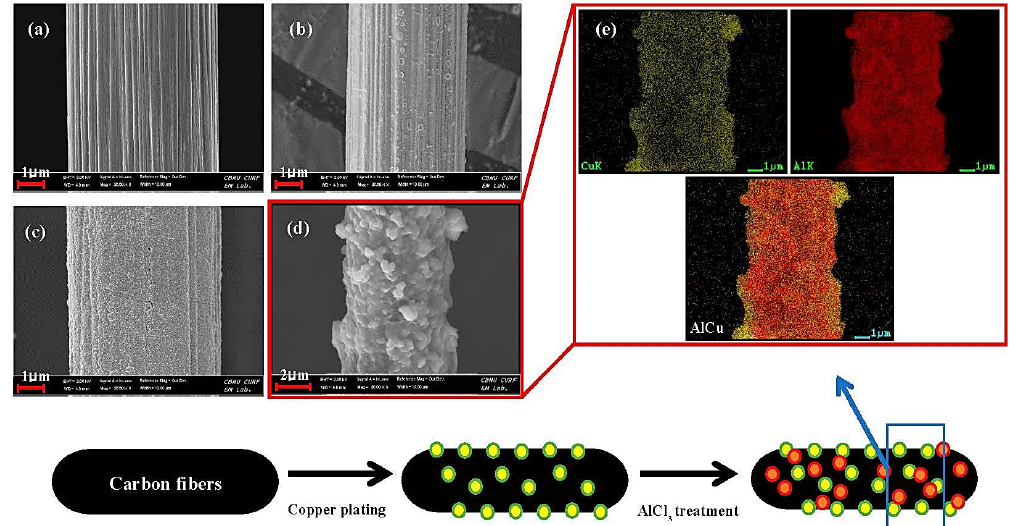
Figure 1. FE ‐ SEM images of the as ‐ synthesized sample with different surface treatments: ( a ) as ‐